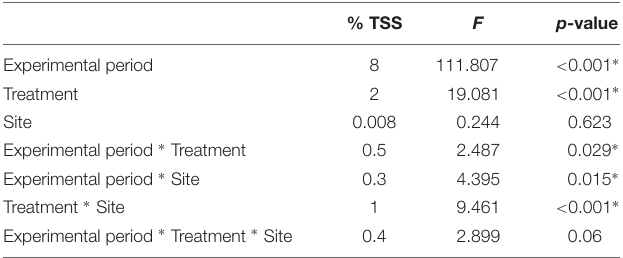
Frontiers in Plant Science |